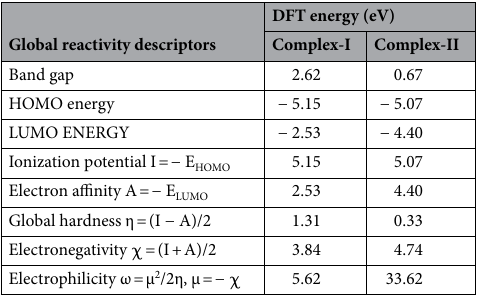
Table 2. Calculated global reactivity properties of the molecule.